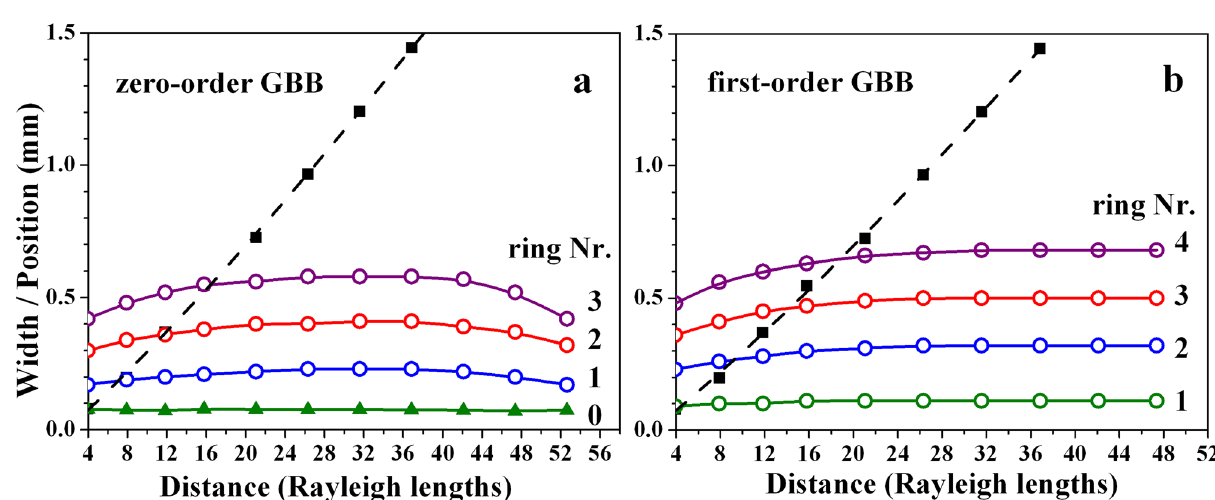
Figure 8. Blue dots/solid line and left scale: Dependence of the first ring radius (FWHM) of the first-order GBB on the r 0 /ω 0 . (One OV remains nested in the beam causing its central part to be doughnut-shaped.) Blue dashed curve—numerical result obtained using Eq. (10). Red triangles/dashed line and right scale: Azimuthally- averaged first ring intensity vs. r 0 /ω 0 extracted from the same set of data. The data are recorded 45 cm (12 z R ) behind the focus of the lens.